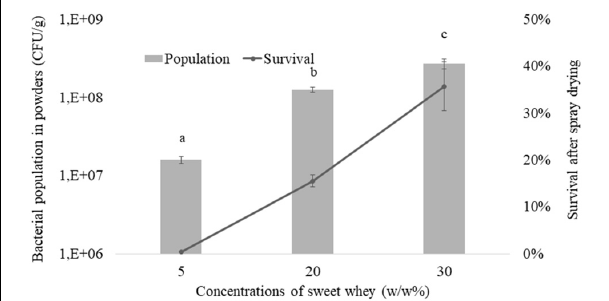
FIGURE 4 | Hyperconcentrated sweet whey improves L. casei BL23 survival during spray drying. Lactobacilli were cultivated 48 hours in isotonic (5%) or hyperconcentrated (20 and 30%) sweet whey. These different cultures were then subjected to spray drying. Live cells were then enumerated in the resulting powders upon rehydratation, by CFU counting. Lactobacilli populations, in CFU per gram of powder, were calculated (left ax). Survival, when comparing live populations before and after spray drying, is reported (right